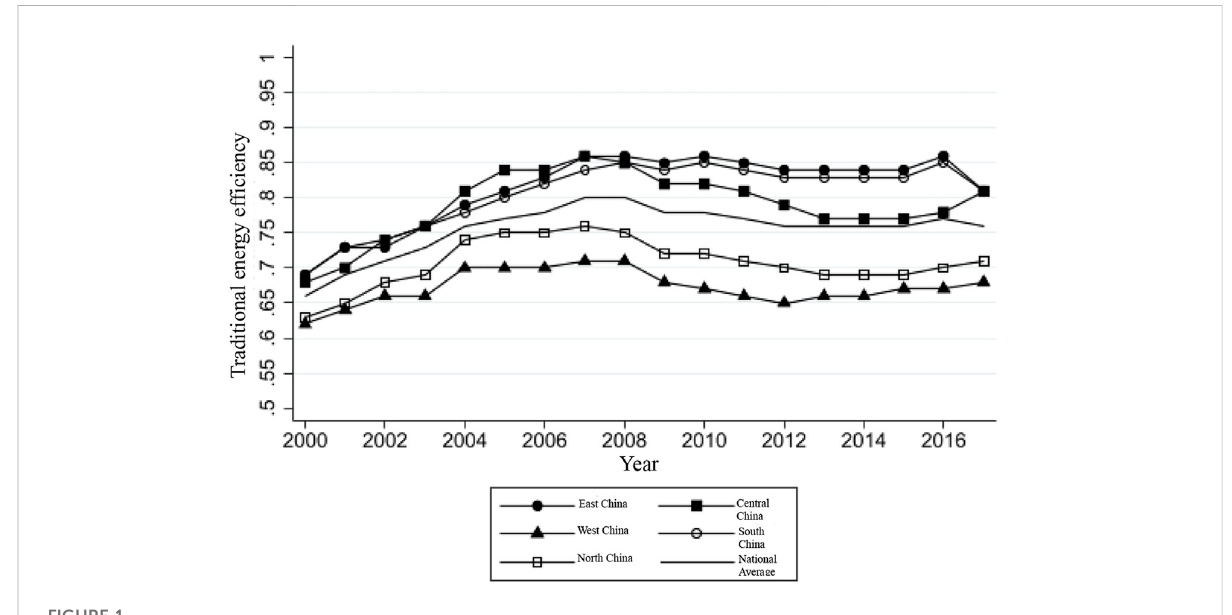
FIGURE 1 2000-2017 fossil energy ef fi ciency structure of China.